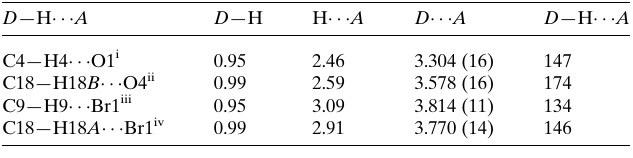
Table 2 Experimental details.